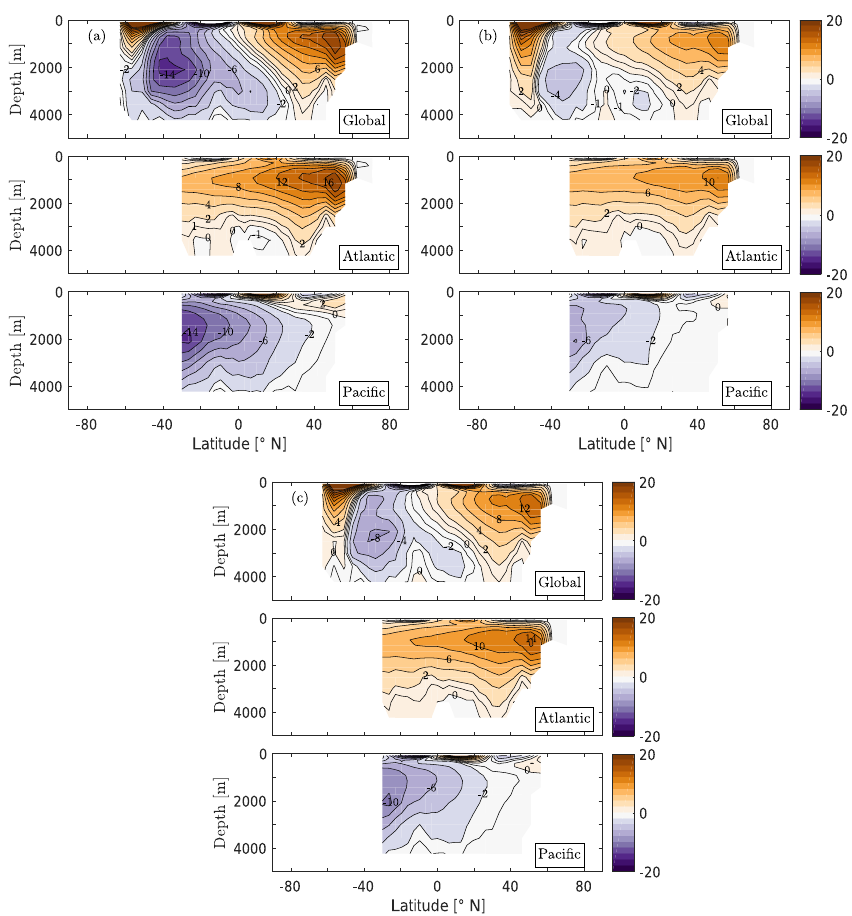
Figure 5. Zonal average overturning stream function ( ψ ) measured in sverdrups (Sv) for (a) DD × 2, with high diapycnal diffusivity, (b) DD / 2, with low diapycnal diffusivity, and (c) the control PIES278. The upper panel in each subfigure shows the global ψ , the mid- dle panel shows only the Atlantic sector and the lower panel shows only the Pacific sector. The southernmost limit for the Atlantic and Pacific sectors is − 30 ◦ N.